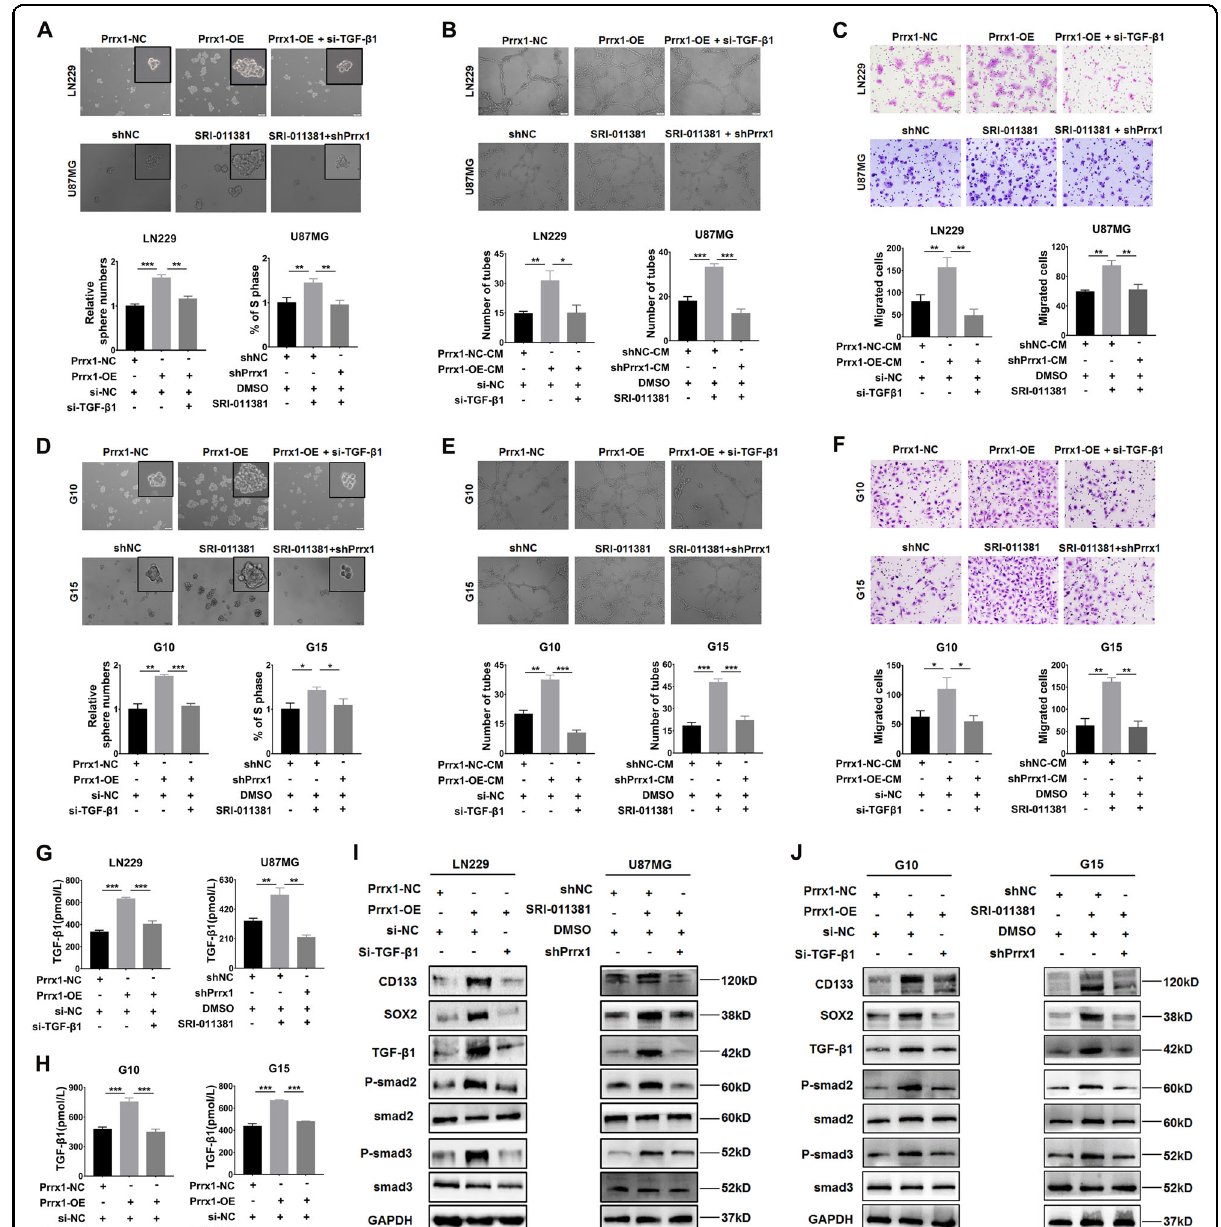
Fig. 6 Prrx1/TGF- β /smad signal axis plays a vital role in Prrx1-mediated stemness and angiogenesis. A Effects of TGF- β pathway agonist SRI- 011381 and TGF- β 1 siRNA on Prrx1 mediated NSTCs stemness acquisition through sphere formation assay. B Effects of SRI-011381 and TGF- β 1 siRNA on Prrx1 mediated NSTCs angiogenesis through tubule formation assay. C Transwell assay indicated the effects of SRI-011381 and TGF- β 1 siRNA on Prrx1 mediated migration of HUVEC treated with NSTCs CM. Scale bar represents 50 μ m. D Effects of SRI-011381 and TGF- β 1 siRNA on Prrx1 mediated GSCs stemness maintenance through sphere formation assay. E Effects of SRI-011381 and TGF- β 1 siRNA on Prrx1 mediated GSCs angiogenesis through tubule formation assay. F Transwell assay indicated the effects of SRI-011381 and TGF- β 1 siRNA on Prrx1-mediated migration of HUVEC treated with GSCs CM. Scale bar represents 50 μ m. G , H Effects of SRI-011381 and TGF- β 1 siRNA on Prrx1 induced TGF- β 1 secretion in NSTCs ( G ) and GSCs ( H ) through ELISA assay. I , J Effects of SRI-011381 and TGF- β 1 siRNA on expression changes of stemness markers (CD133 and SOX2) and TGF- β / smad pathway proteins (TGF- β 1, P-smad2, and P-smad3) modulated by Prrx1 in NSTCs ( I ) and GSCs ( J ). * P < 0.05, ** P < 0.01, *** P < 0.001.